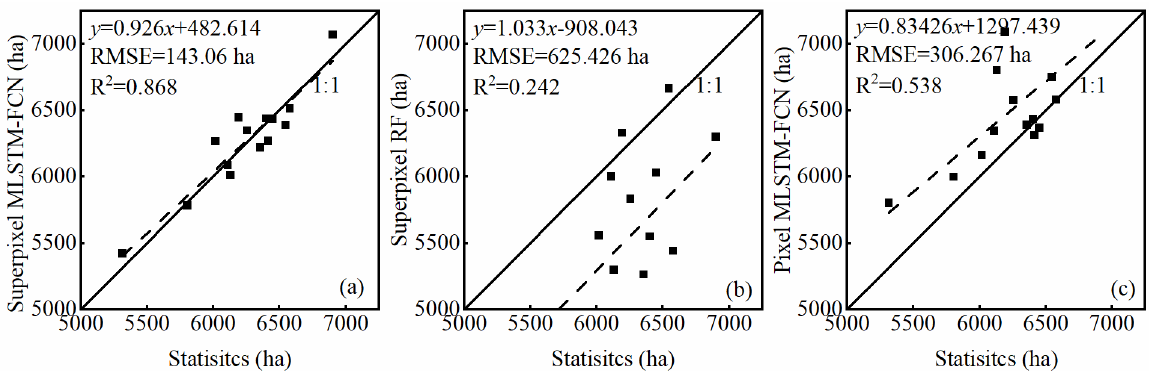
Figure 7. Correlations between agricultural statistics and mapped area by ( a ) superpixel MLSTM- FCN, ( b ) superpixel RF, and ( c ) pixel MLSTM-FCN.